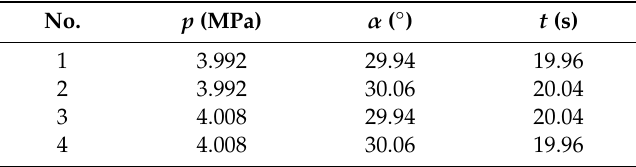
Table 9. Virtual samples based on the first experimental sample.